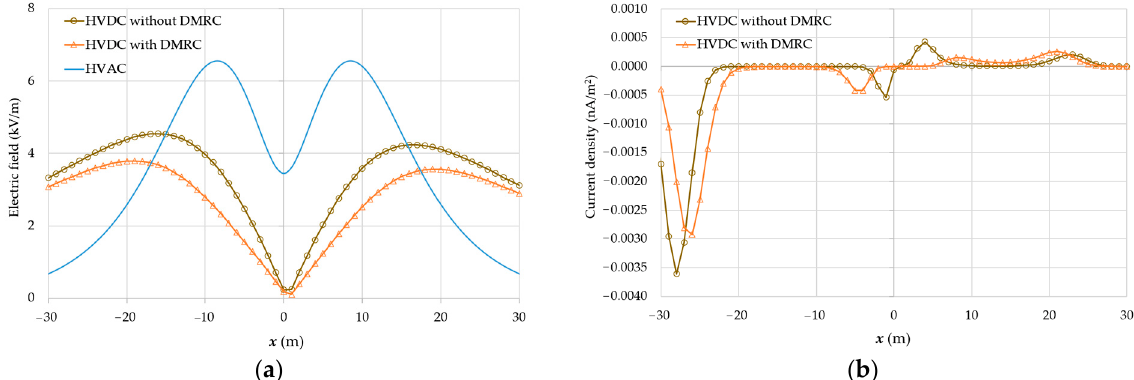
Figure 8. Electric field magnitude and ion current density at the ground-level of the ±500 kV configuration with and without DMRC under the no wind condition: ( a ) electric field magnitude; ( b ) ion current density.